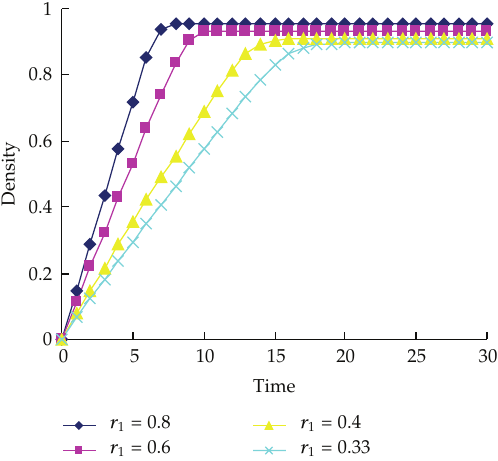
Figure 5: Average density of the platform along time with di ff erent r 1